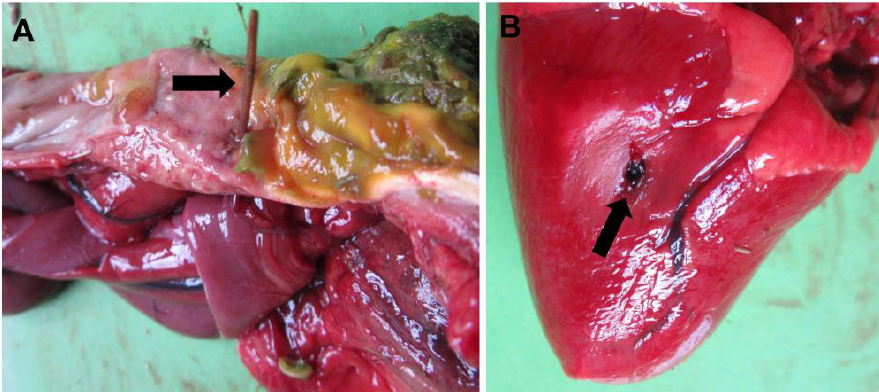
Figure 7. Proventriculus perforation with a briar branch ( A , arrow) and subsequent right heart ventricle perforation ( B , arrow) in a